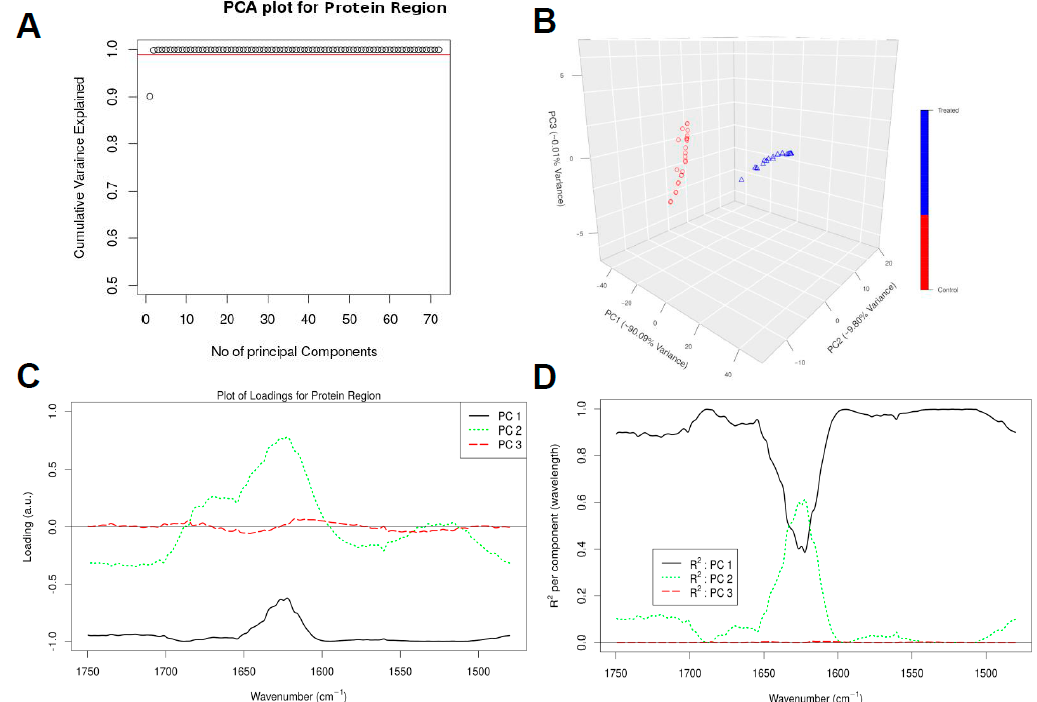
Figure 4. Chemometric analysis of FTIR experimental data on the protein region (1750–1480 cm − 1 ). Amount of variance captured by PCs ( A ), PCA score plot ( B ), loading plots for the spectral data ( C ), and squared correlation for the first 3 PCs for the spectral collection ( D ).